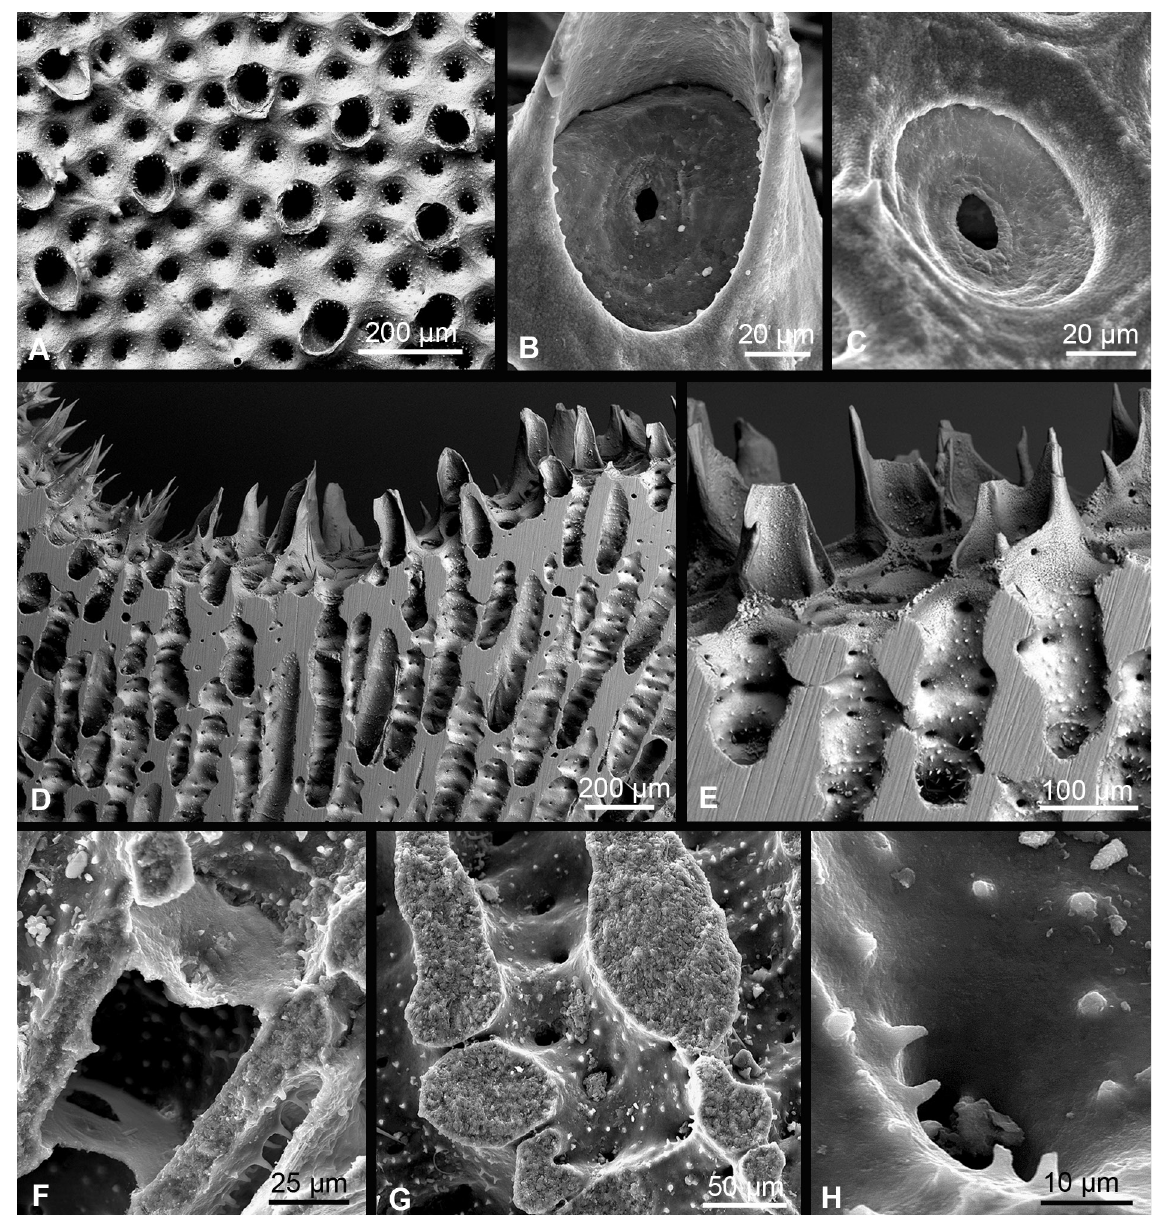
Fig. 4. Disporella guada Harmelin, Taylor & Waeschenbach sp. nov. A . Paratype (NHMUK 2021.2.25.1). B–C, F–H . Holotype (MNHN-IB-2017-696). D–E . Paratype (NHMUK 2021.3.19.1). A . Frontal view of autozooids with short peristomes interspersed with kenozooids. B–C . Calcified diaphragms with a central lumen closing an autozooid (B) and a kenozooid (C). D–E, G . Longitudinal sections of